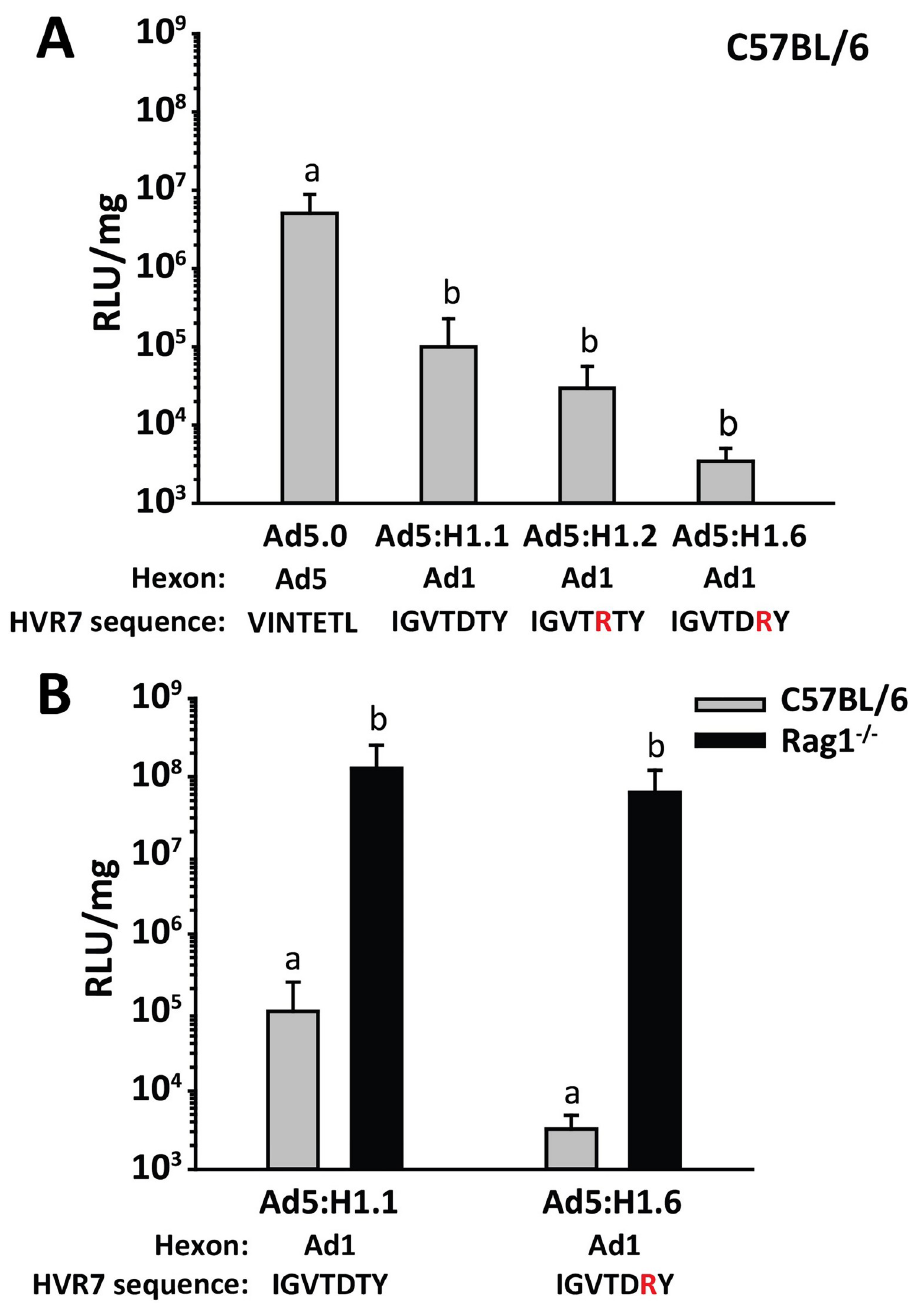
Fig 8. Liver transduction following IV injection of mice with vectors with chimeric hexon from Ad1. Mice were injected IV with 4x10 11 vp/kg of vector, and liver luciferase expression was measured 48 h later. (A) Liver luciferase expression after IV injection of C57BL/6 mice with Ad5 vector (Ad5.0) or Ad5 vectors with chimeric Ad1 hexon (Ad5: H1.1) or mutated Ad1 hexon (Ad5:H1.2, Ad5:H1.6). Mutated residues in HVR7 are indicated by red letters. (B) Liver luciferase expression after IV injection of Rag1 -/- mice compared to C57BL/6 mice. n = 5 mice per group. Statistical comparison was performed by ANOVA and Holm-Sidak post-hoc tests, and groups that do not share the same letter are significantly different from each other ( P �